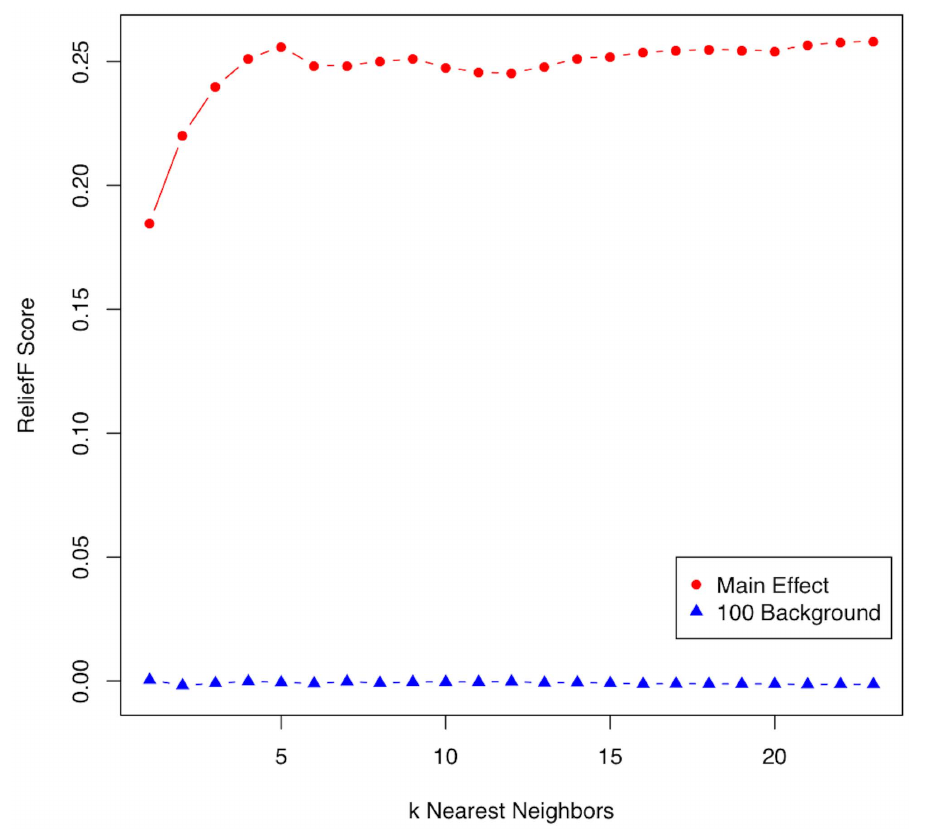
Figure 2. Illustration of the effect of the number of nearest neighbors (k) on the Relief-F score for a main effect transcript (red circles) from one of the simulated data sets. The vertical axis is the Relief-F importance score (Equation (1)); the horizontal axis is the number of nearest neighbors, k. For main effects, a larger k is suggested because Relief-F converges to a univariate attribute estimator (myopic). For comparison, the average scores for 100 random null transcripts (blue triangles) in the data set are plotted versus k. Regardless of k, the Relief-F scores remain low for noise genes.